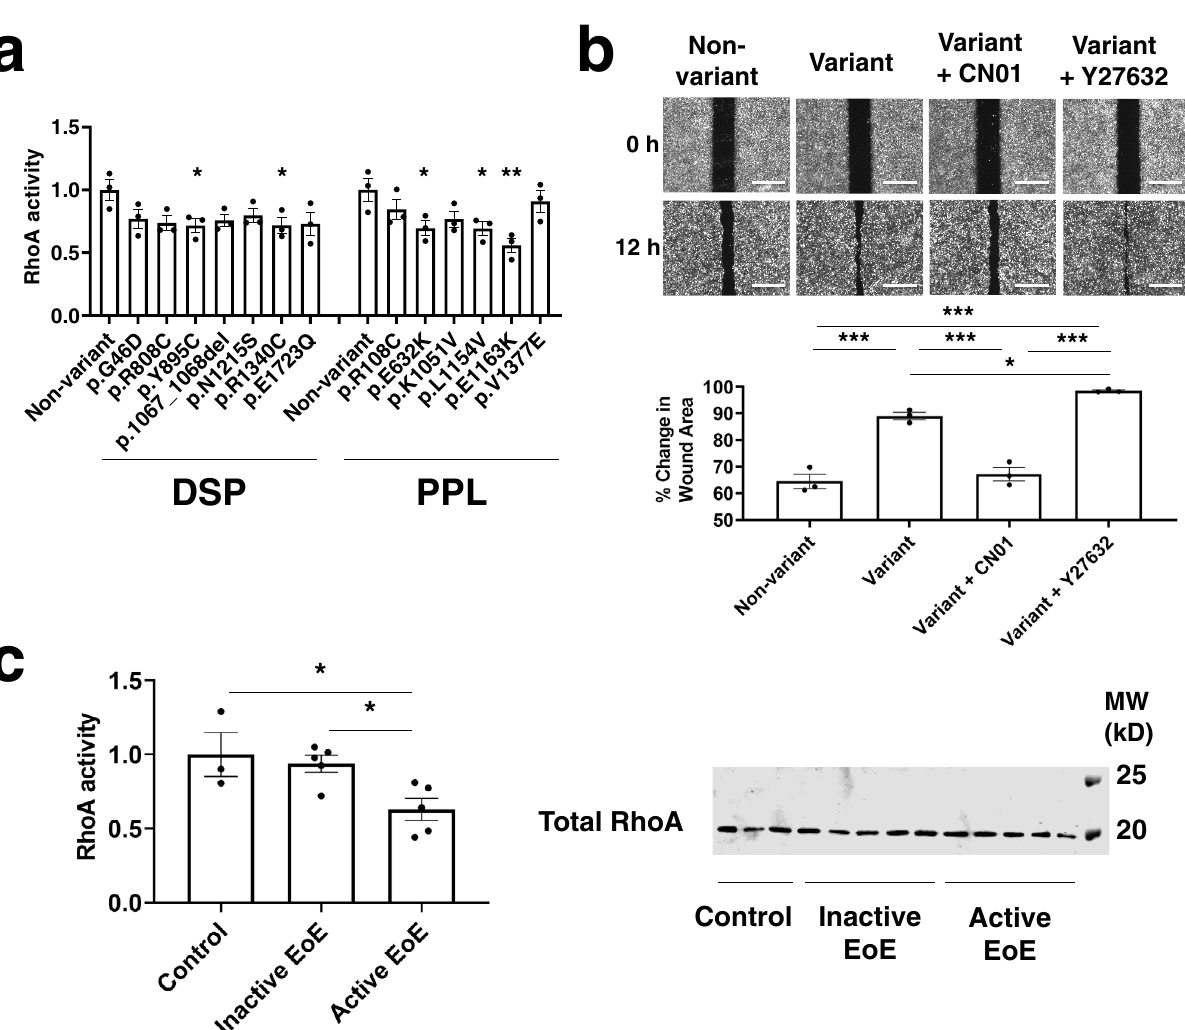
Fig. 4 Effect of DSP and PPL variants on RhoA activity. a Active RhoA assays performed in EPC2 cells transduced with constructs encoding non-variant and mutated DSP or PPL. Statistics (versus non-variants): p.G46D, P = 0.132; p.R808C, P = 0.0691; p.Y895C, P = 0.0453; p.1067_1068del, P = 0.1013; p.N1215S, P = 0.2131; p.R1340C, P = 0.048; p.E1723Q, P = 0.0619; p.R108C, P = 0.4849; p.E632K, P = 0.0443; p.K1051V, P = 0.1589; p.L1154V, P = 0.0419; p.E1163K, P = 0.0035; p.V1377E, P = 0.8738. b Wound healing assays performed in EPC2 cells transduced with constructs encoding